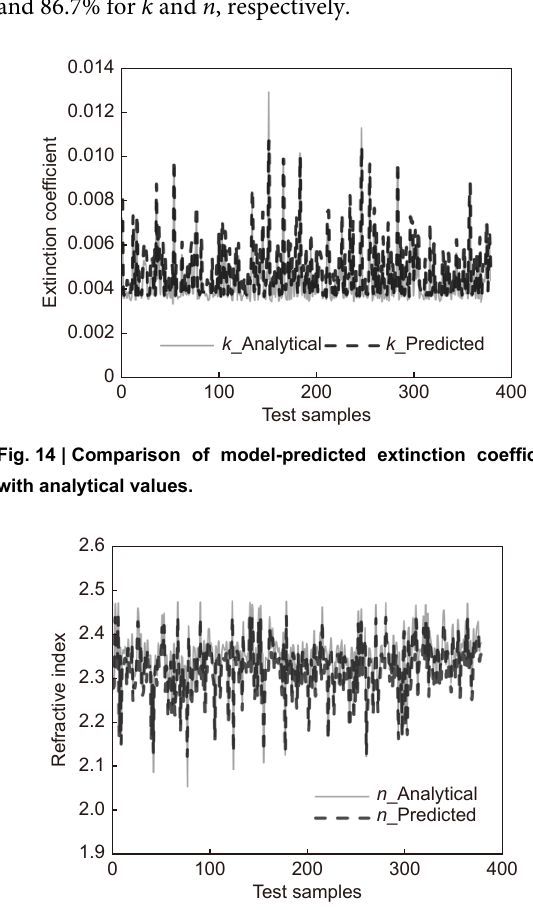
Fig. 15 | Comparison of model-predicted refractive index with analytical values.